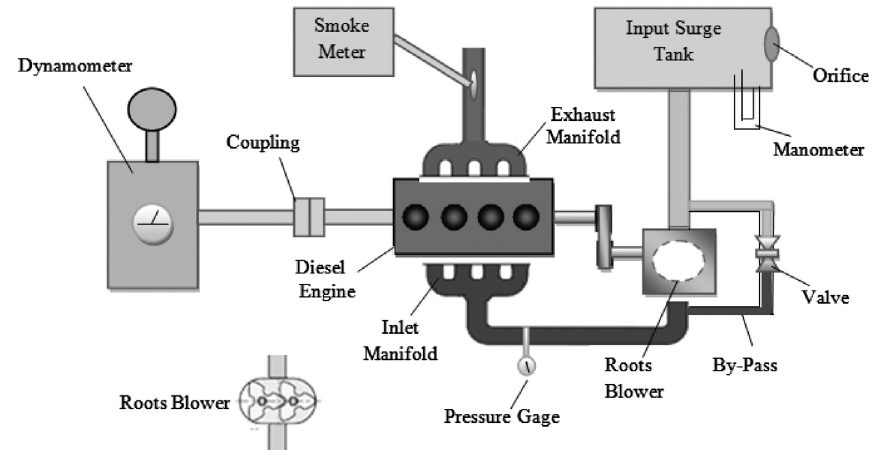
Fig. 1. Experimental layout for tests on the diesel